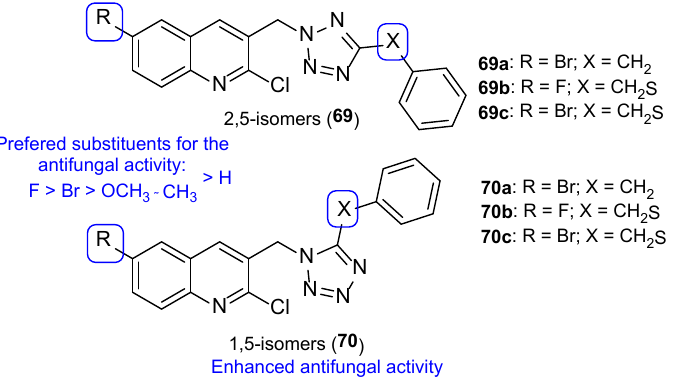
Figure 36. Chemical structures of 2,5-isomers 69a – c and 1,5-isomers 70a – c and SAR [116]. In 2013, Antypenko et al. synthesized a series of compounds and tested them for their (Figure 37) was the most potent compound, with DIZ of 22 mm at the concentration of 100 µg/disk (when compared to nystatin, the standard, with DIZ of 21 mm at the concentra-